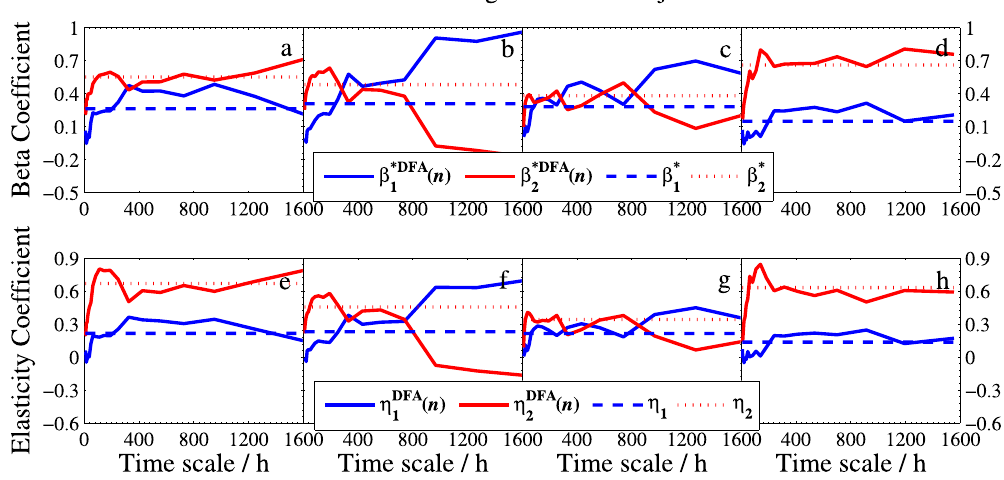
Figure 12. Beta coefficients and elasticity coefficients of bivariate DFA and standard regression model of Tianjin with the same legend as in Fig. 11. Here the subscripts 1 and 2 denote Beijing and Baoding, respectively.